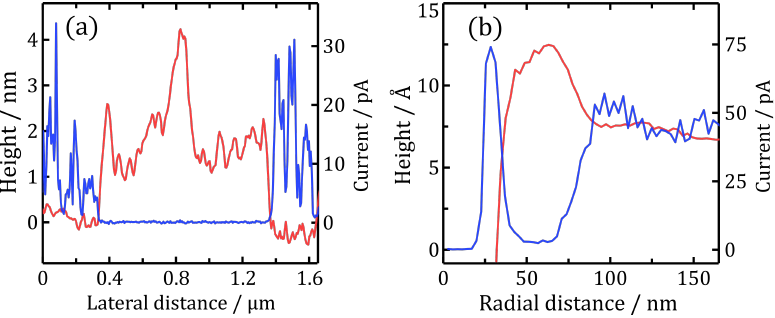
Figure 2. ( a ) Height (red line) and photocurrent (blue line) cross sections of the insulating layer, acquired from blue dashed lines in Figure 1c,g; ( b ) Average radial height (red line) and photocurrent (blue line) cross sections of a V-pit ridge, centred on the V-pit marked by red circles in Figure 1c,g. PC-AFM results gained from the In 0.05 Ga 0.95 N and In 0.09 Ga 0.91 N samples (Figure 1a,b,e,f) are